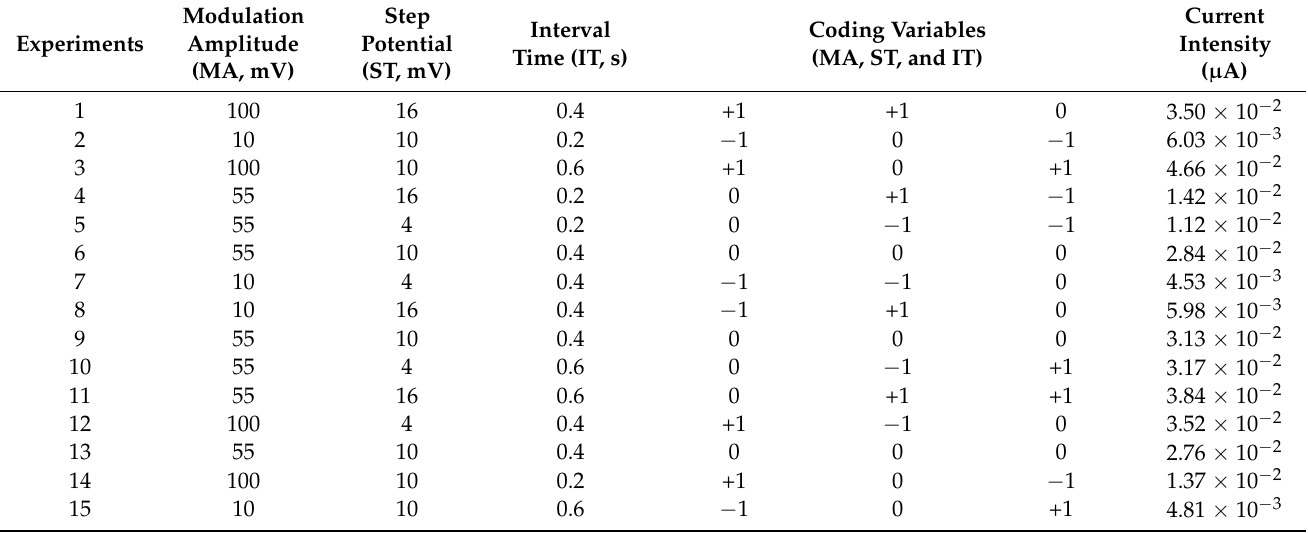
Figure 2. Voltammogram with the final peak signal of tryptophan (2 mg/L) after adjusting the measurement conditions. Table 3. Box–Behnken design for optimizing electroanalytical experimental